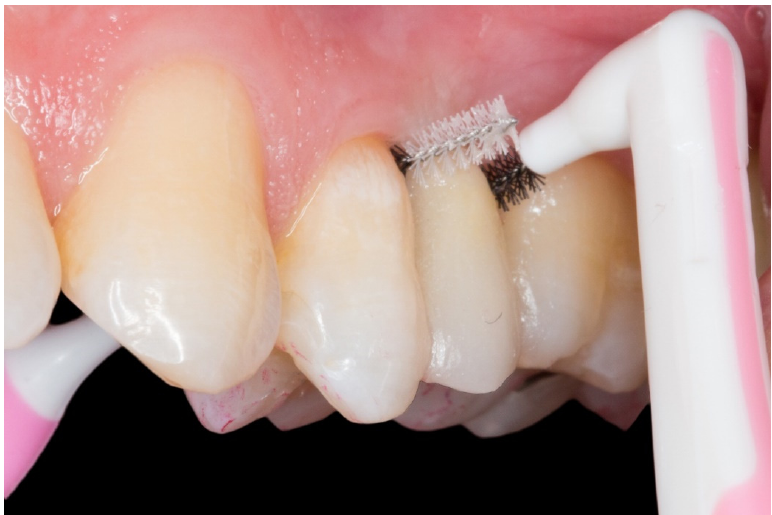
Figure 7. The FRCB after the occlusal adjustment and composite polishing.